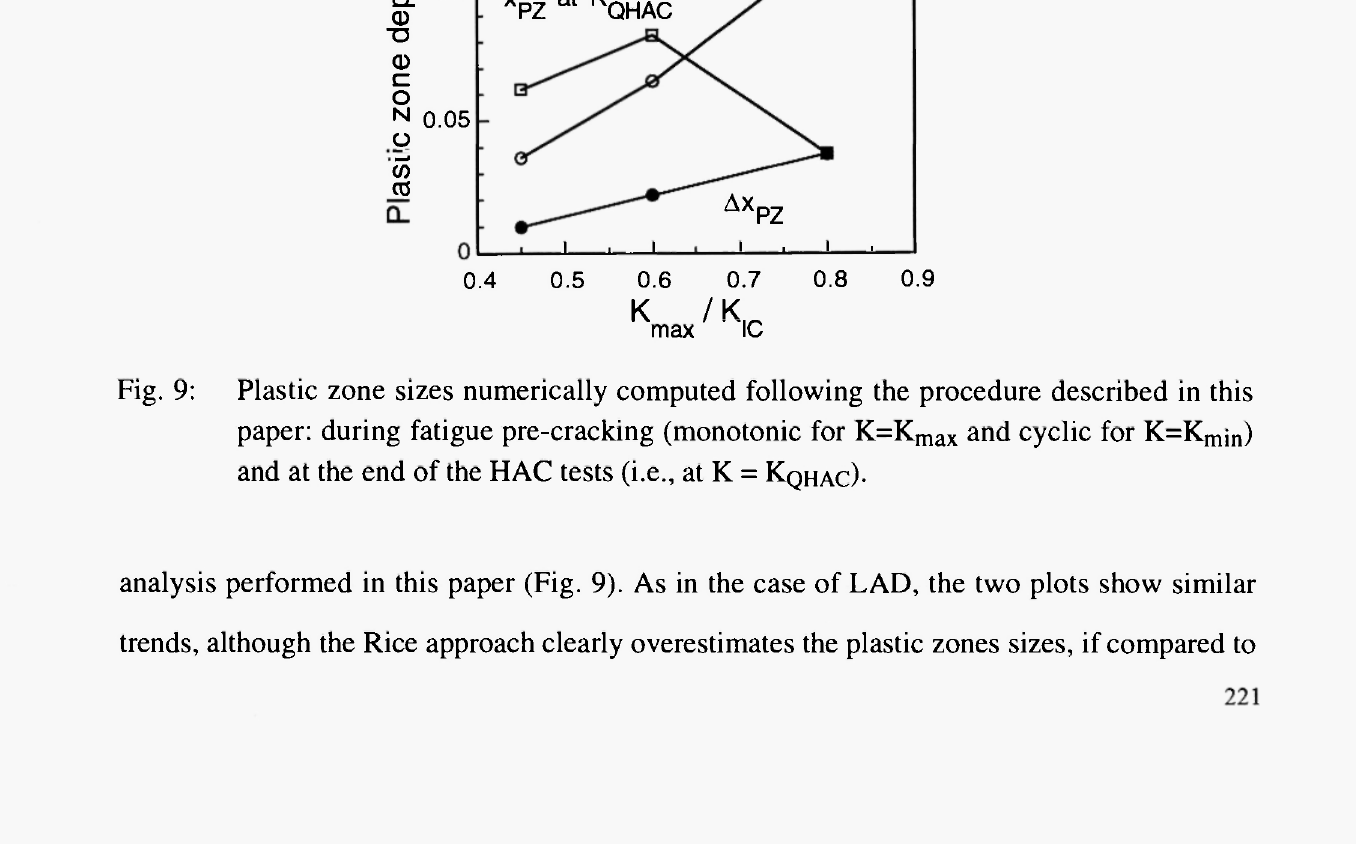
and cyclic for K=K j ) and at max m n